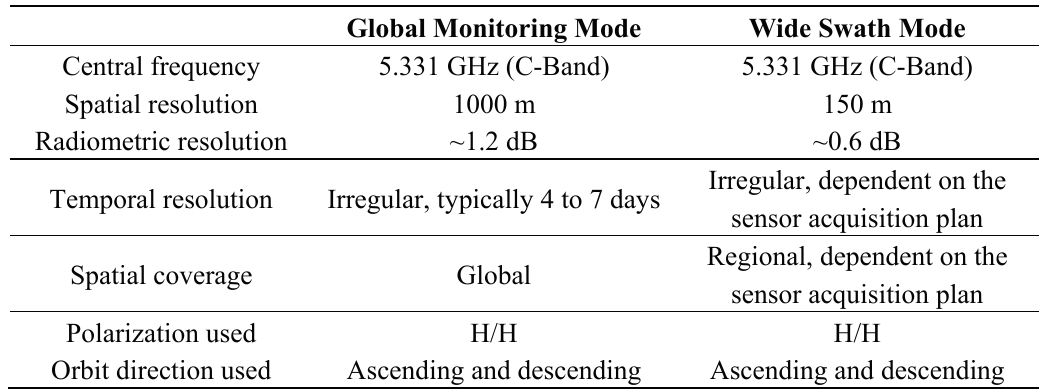
Table 1. The characteristics of the Advanced Synthetic Aperture Radar Global Monitoring mode and Wide Swath mode